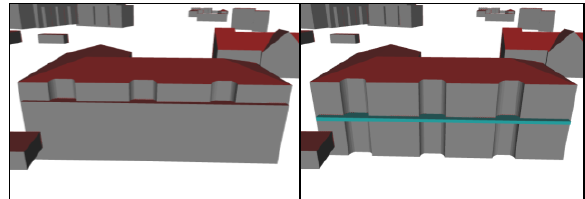
Figure 4. Reclassification and remodelling of class 13 objects (flying roofs) from buildings to building installations. Left: the original dataset, right: the remodelled object (in